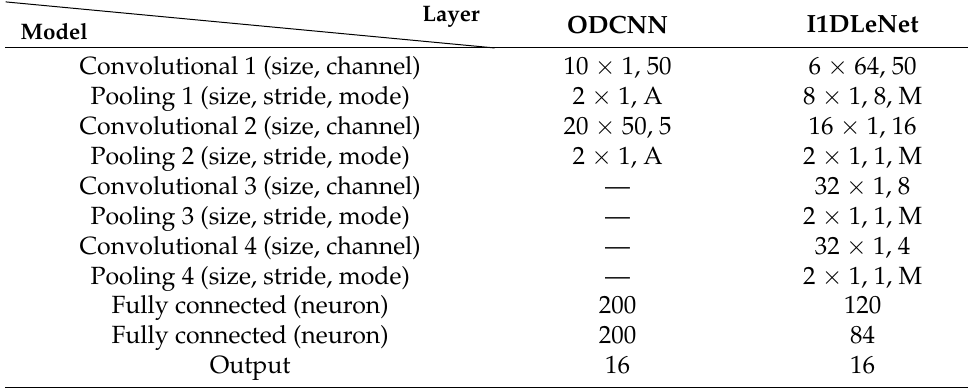
Table 4. ODCNN and I1DLeNet